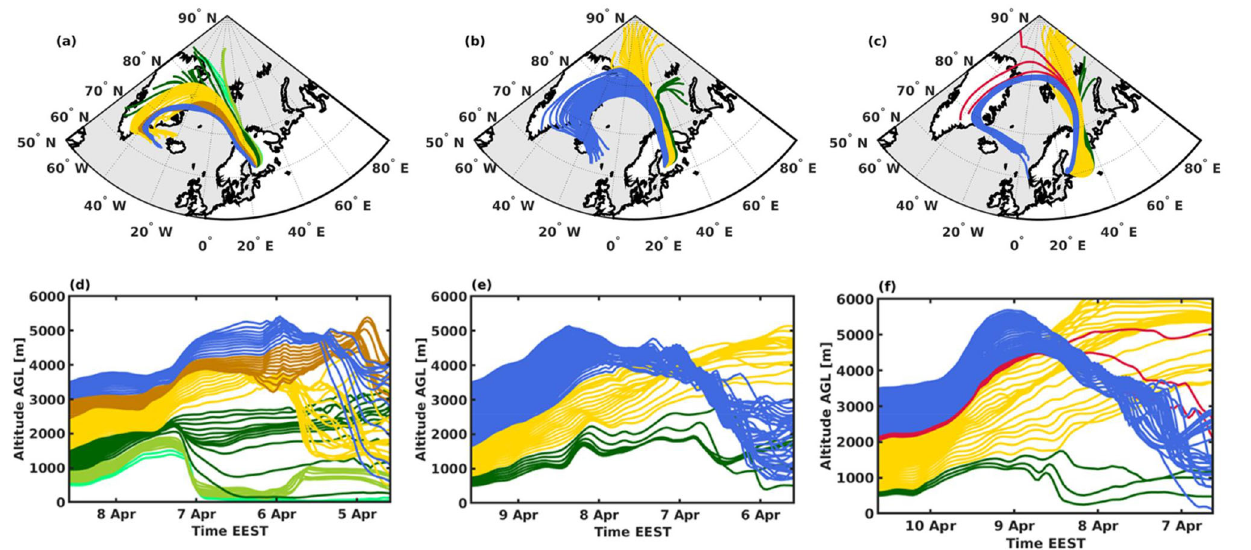
Figure 3. HYSPLIT 96h backward trajectories arriving at Hyytiälä calculated every 50m in altitude from 500 to 3500m. Panels (a–c) show spatial coverage and panels (d–f) display the trajectory altitude over time. Trajectories with similar origin/altitude properties are combined into layers with the same colours as the layers identified with HSRL in Fig. 1c. Panels (a) and (d) show trajectories arriving on 8 April at 17:00, panels (b) and (e) on 9 April at 17:00 and panels (c) and (f) on 10 April at 14.00.